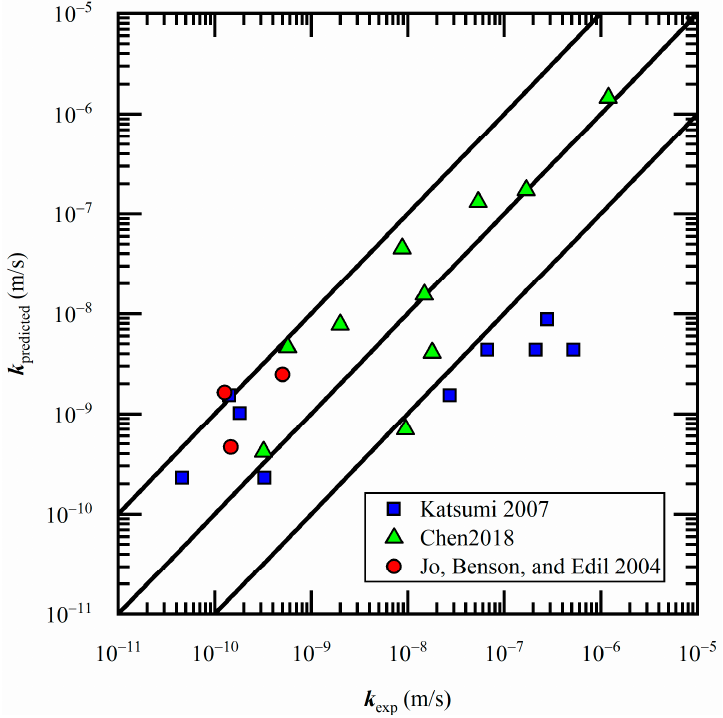
Figure 9. Comparison of predicted and experimental values.